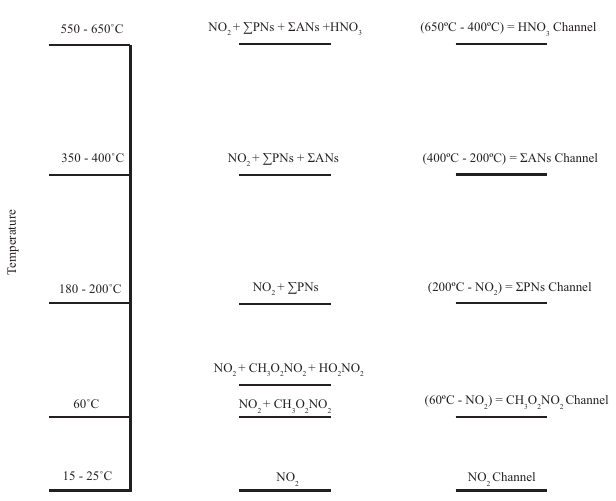
Figure 5. Schematic of the species measured in the TD- LIF channels and the temperature set points (tempera- tures the species dissociate) for those channels. (cid:54) PNs ≡ PAN + PPN + CH 3 O 2 NO 2 + HO 2 NO 2 + ... and (cid:54) ANs ≡ alkyl and multifunctional nitrates. The channel subtracted to calculate the measured species (e.g., CH 3 O 2 NO 2 ) is shown before the equals sign in the third column.